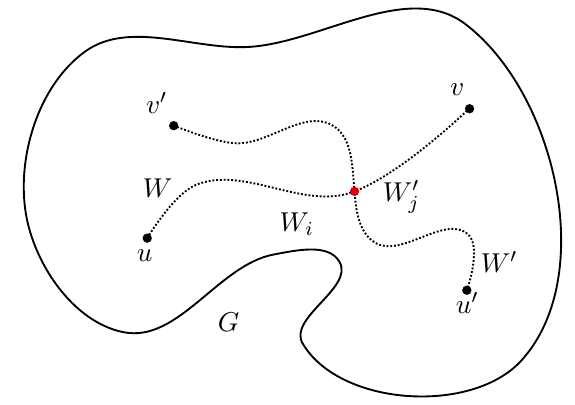
FIG. 5. Shown are walks W from u to v and W (cid:10) from u (cid:10) to v (cid:10) . Walks may intersect at a vertex (red) such that the i th location of W and the j th location of W (cid:10) are the same, i.e., W i = W (cid:10) say that W and W (cid:10) interfere if there exist i , j with | i − j | ≤ 1 such . We show that, with high probability, there exists that W i = W (cid:10) j a set of walks for a permutation σ of order two on V ( G ) that connect v to σ(v) such that the number of interfering walks can be bounded. SWAP s along sets of walks that do not interfere with each other significantly parallelize the routing